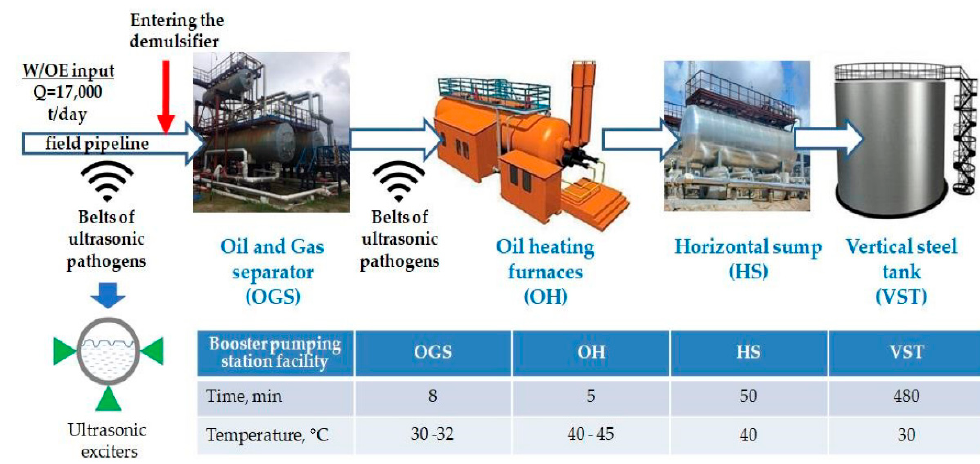
Figure 3. Schematic diagram of the study of ultrasonic effects on the separation of water-in-oil emulsions at a field in Western Siberia (Russian Federation).